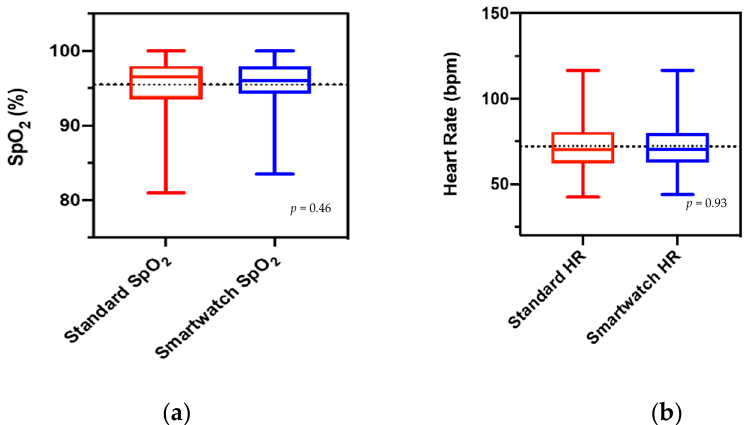
Figure 3. Boxplots of the mean differences between the smartwatch and the standard commercial device. ( a ) Mean difference in SpO2 between the smartwatch and the standard commercial device ( p = 0.46) ( b ) Mean difference in HR between the smartwatch and the standard commercial device. ( p = 0.93).